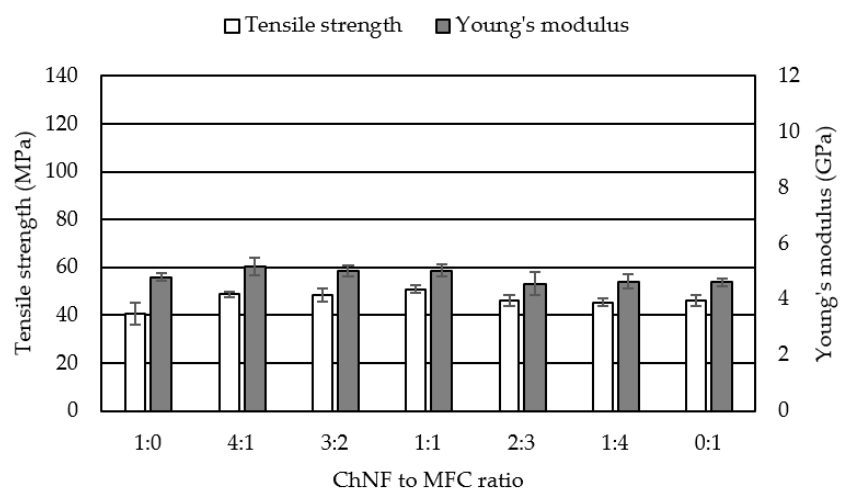
Figure 3. Tensile strength and Young’s modulus of nanocomposites with 25 wt % reinforcing phase with varying chitin nanofiber (ChNF) to microfibrillated cellulose (MFC) ratios.